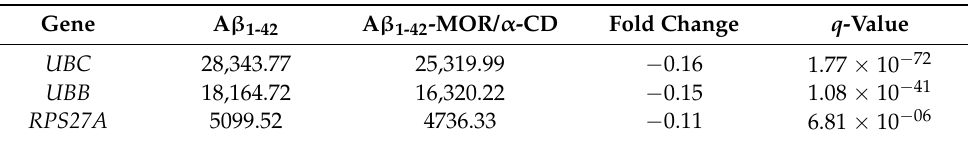
Fold change for each gene obtained from differentially expressed gene analysis between A β 1-42 against A β 1-42 - MOR/ α -CD-treated